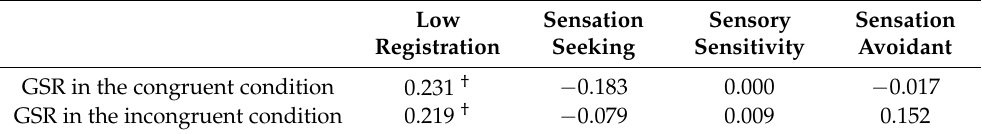
Low Sensation Sensory Sensation Registration Seeking Sensitivity Avoidant